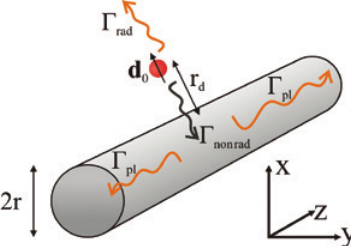
Figure 1: Schematic illustration of the individual decay channels of a dipole emitter d located at a distance r next to a metallic 0 d nanowire. The emitter (orange sphere with black arrow) decays by emitting a single photon, which is directed into free space, into ohmic losses of the metallic wire, or into the single plasmonic mode propagating along wire. Γ , Γ , and Γ denote the decay rates to rad pl nonrad the radiation field, the propagating surface plasmon mode, and the metallic loss channels, respectively. The ratio between the different rates is determined by the distance between the dipole emitter and the wire, r d